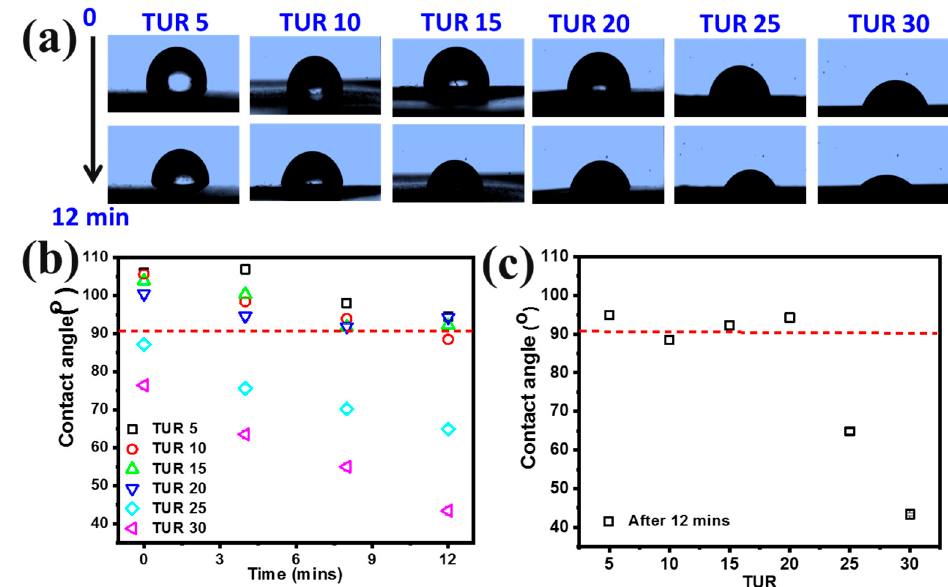
Figure 2. ( a ) Photographs of the water droplet on different PE/EMAA film surfaces; ( b ) contact angle as a function of time at various take up ratios (TURs); ( c ) static contact angle after 12 min.